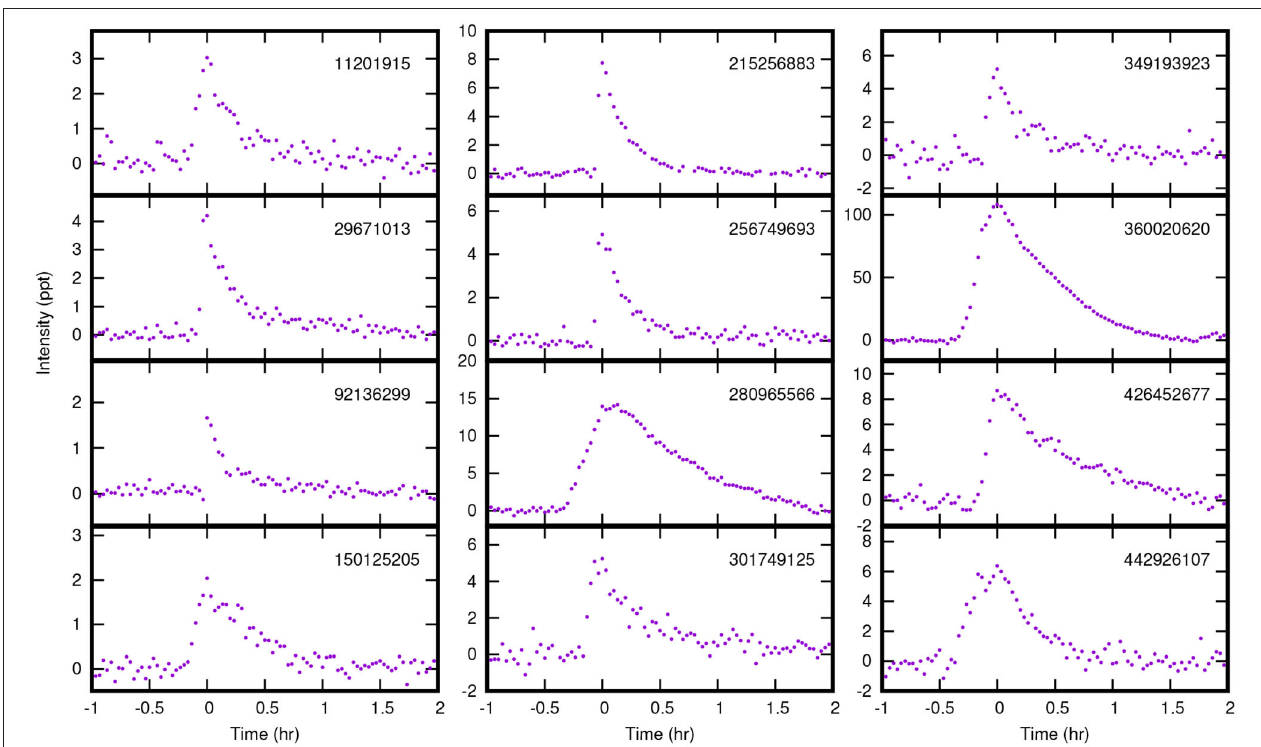
FIGURE 2 | Examples of A star flares in the TESS data. The time origin is the time of maximum flare intensity. Time is in hours and intensity if parts per thousand.